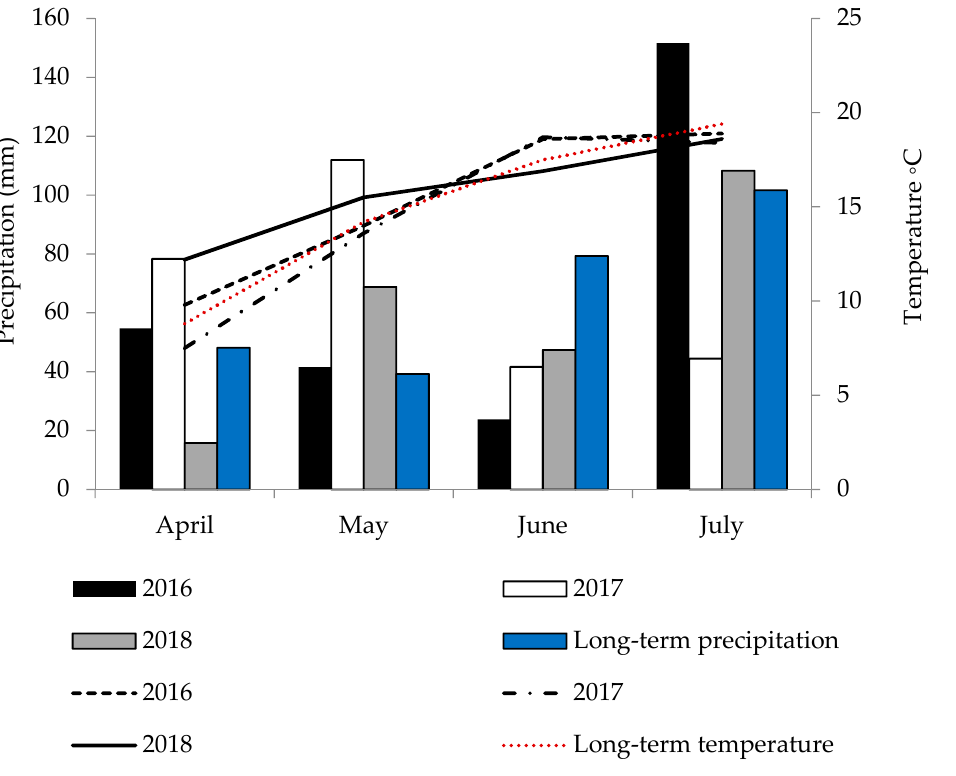
Figure 1. Mean monthly air temperature and total rainfall.